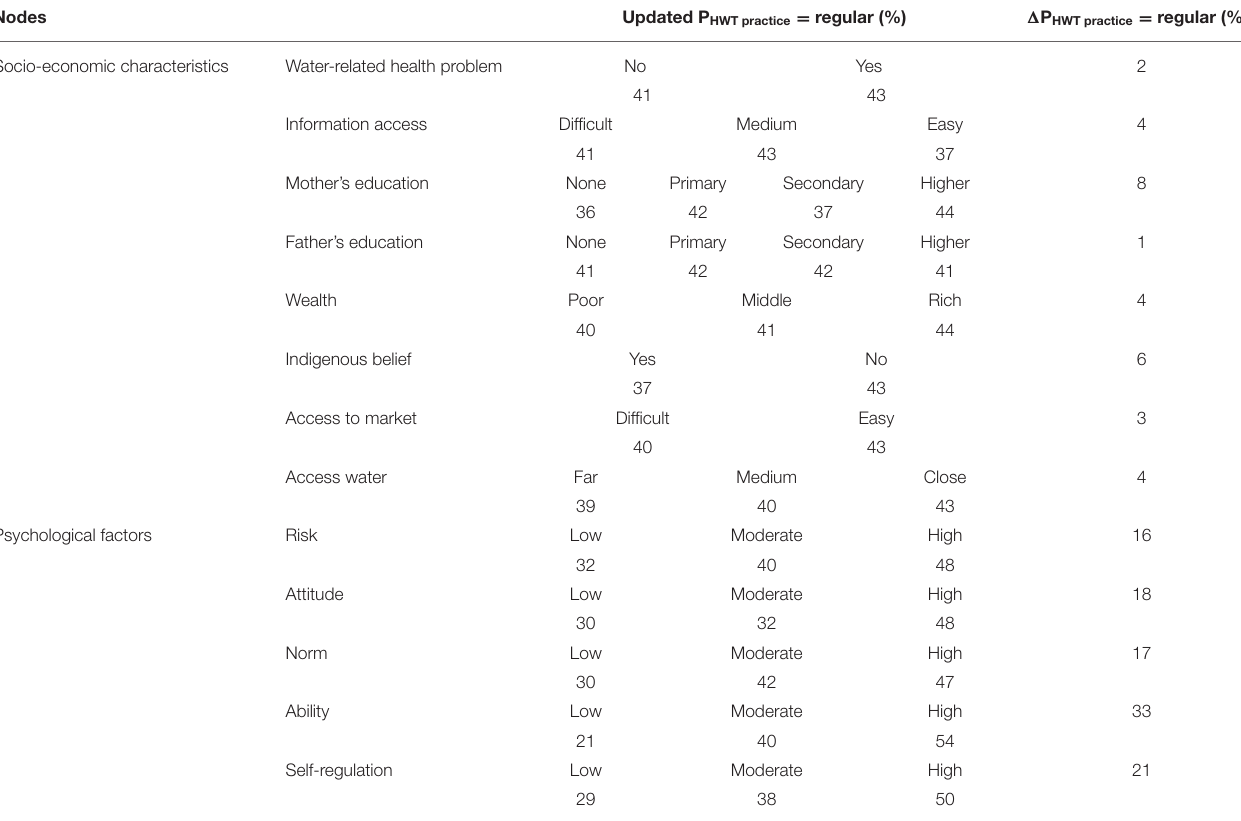
TABLE 3 | Predictive inference that measures the effect of each state in each node on HWT practice .